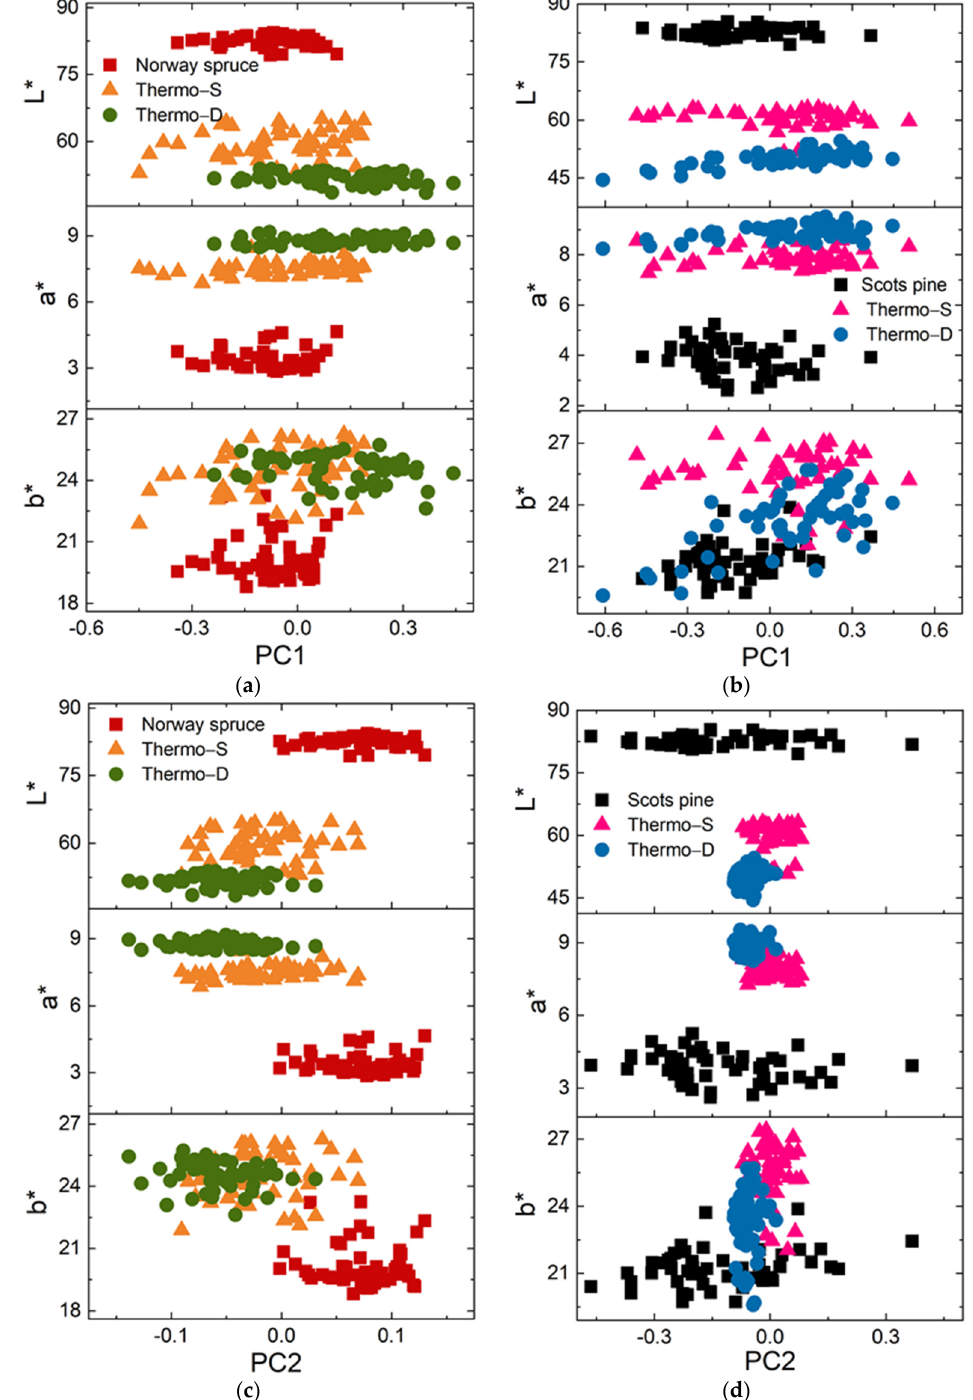
Figure 5. L*, a*, and b* parameters plotted as a function of PC1 ( a , b ) and of PC2 ( c , d ) scores for the untreated and Thermo-Wood ® Norway spruce ( a , c ) and Scots pine ( b , d ). In Figure 6, the measured modulus of elasticity (MOE) and the modulus of rupture (MOR) values for the untreated and ThermoWood ® Norway spruce and Scots pine wood are presented. The MOE and MOR values for untreated timber were similar, but they varied for the Thermo–S and Thermo–D treated wood species, being higher for Norway spruce wood as a result of the higher–than–expected density of the Thermo–D samples. However, the statistical variation bars show a degree of overlap between all specimens